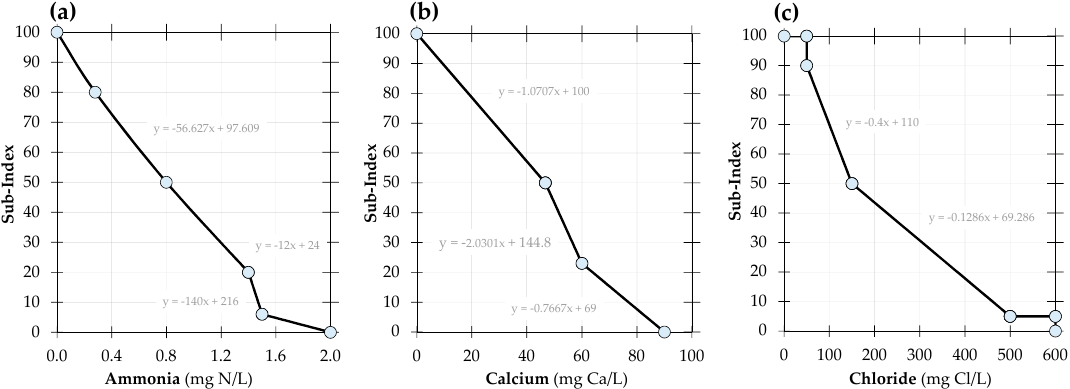
Figure 3. Examples of the graphically established parameter sub-index rating curves for the selected water quality parameters ( a ) NH 3 , ( b ) Ca and ( c ) Cl. Table 4. Range of water quality parameters and their key points defined for sub ‐ index rating curves. Variable